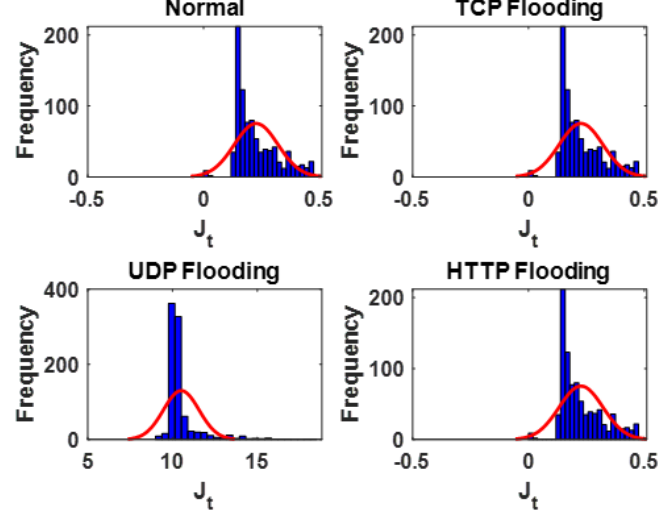
Figure 5. The distributions of J t metrics for various SDN